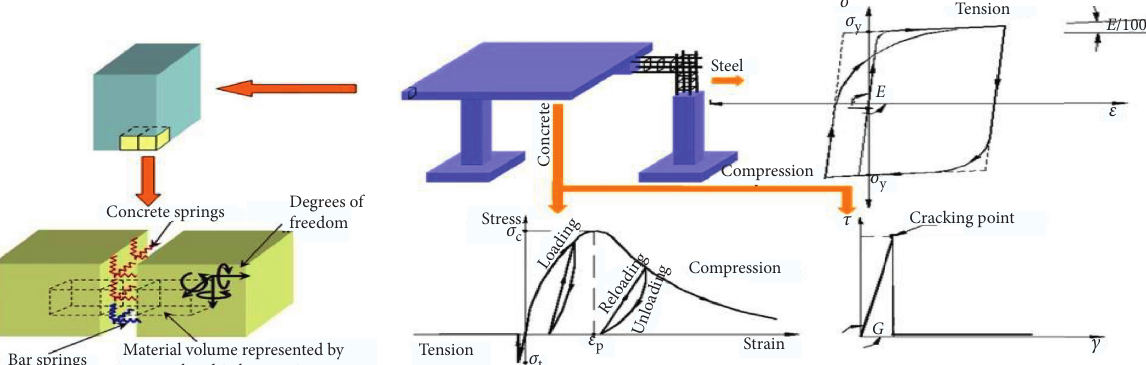
Figure 1: Modeling of a structure with AEM [9].